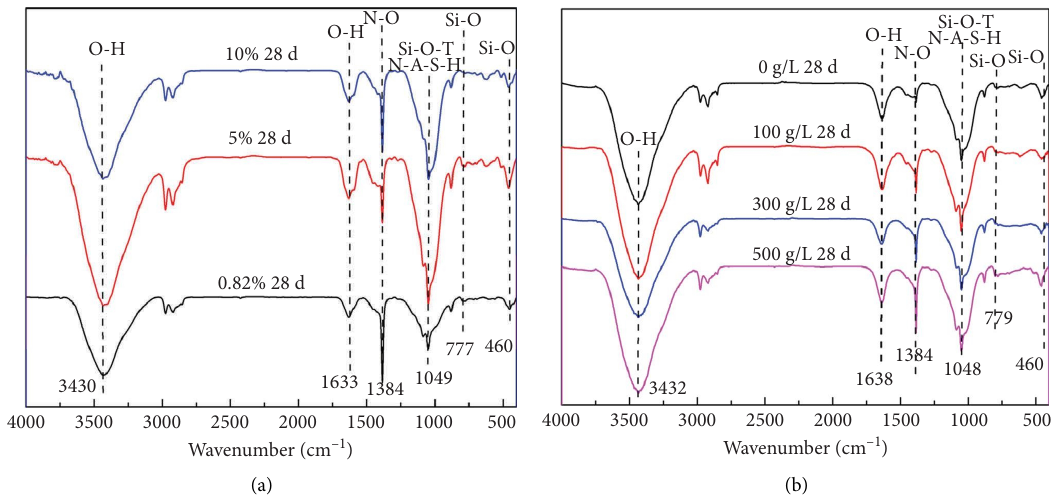
Figure 11: Te IR curves of the SFCM after curing at 90 ° C for 28d. (a) Sodium hydroxide contents; (b) sodium nitrate concentrations.